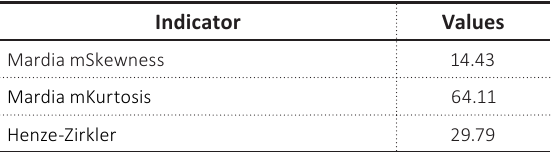
Table 4. Mardia’s multivariate normality test